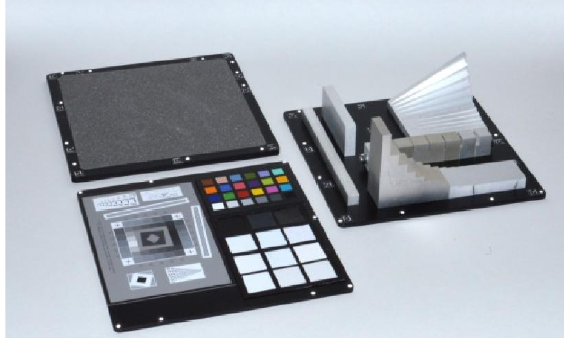
Figure 3. The portable metric test object. Secondary plates with colour and resolution